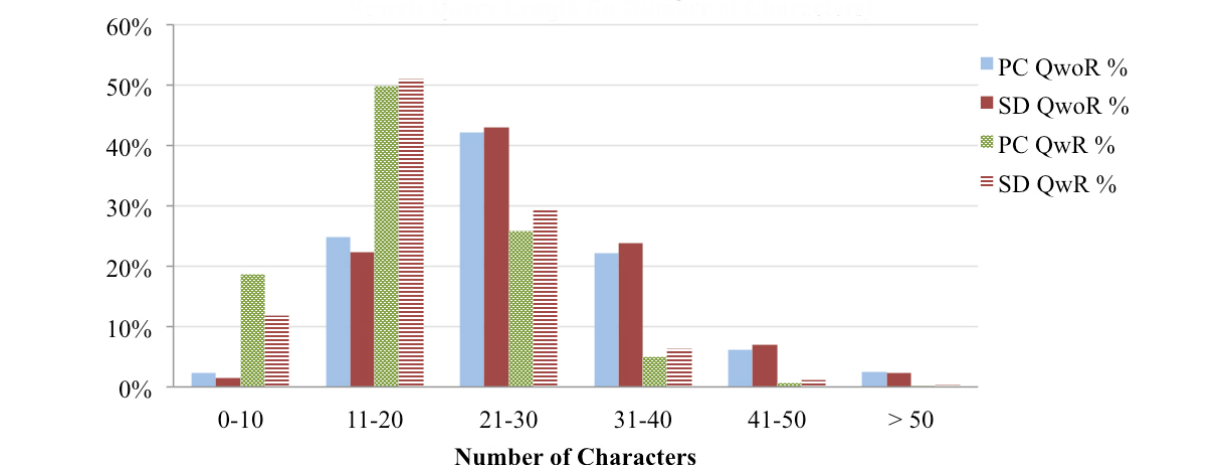
Figure 4. Distribution of the search queries by number of characters.